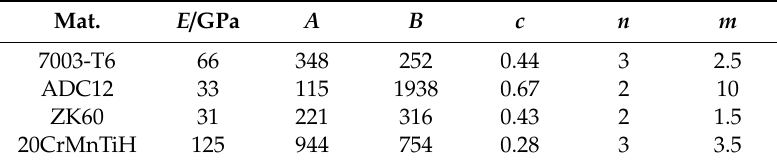
Figure 3. The representative FEM model for ZK60 alloy, ( a ) smooth tensile test, ( b ) pure shear test, ( c ) notched tensile test and ( d ) tensile and notched tests. Table 3. Parameters for numerical simulation.